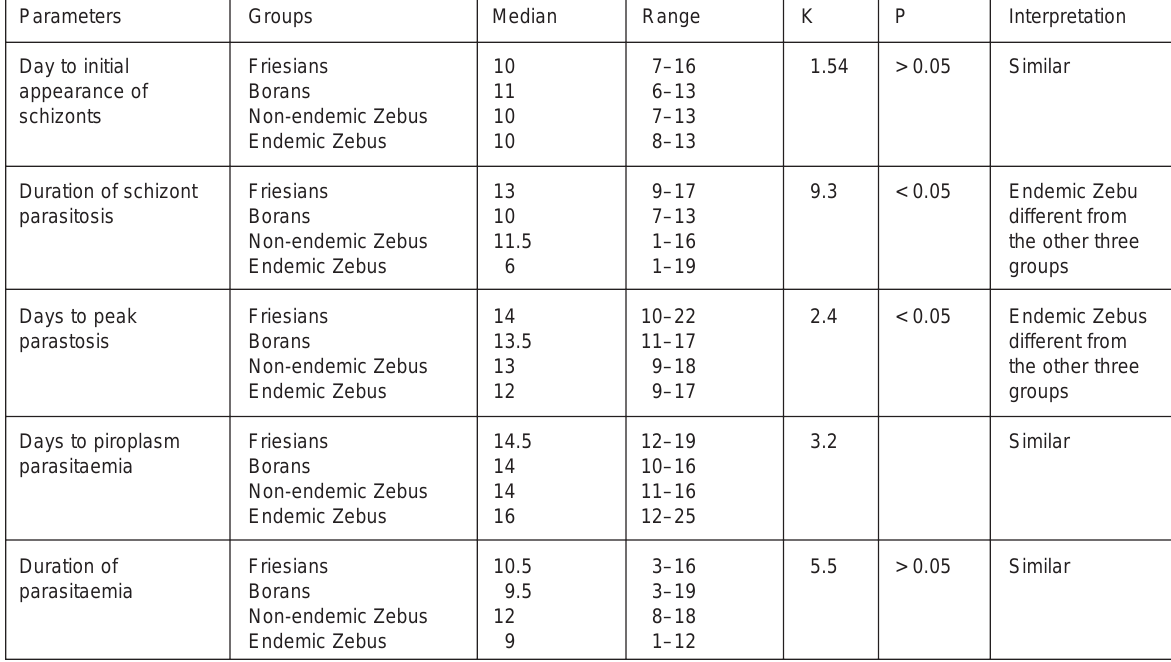
TABLE 2 Comparisons of parasitological parameter responses